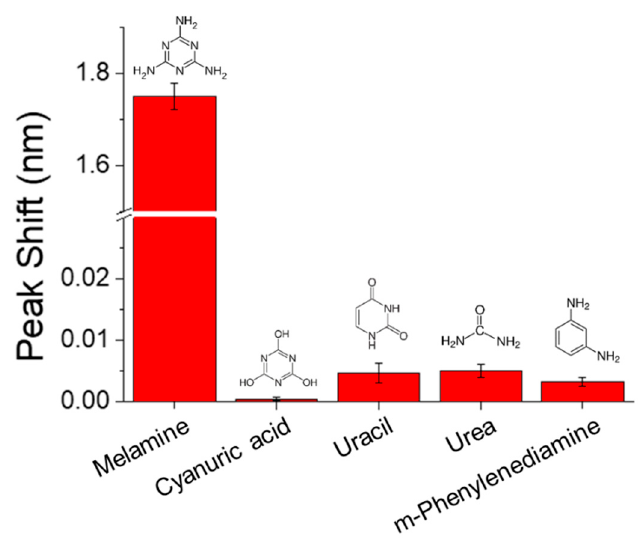
Figure 4. Melamine selectivity of p -NA-based cuvette-type LSPR sensor from DW additionally containing various harmful additives such as melamine, cyanuric acid, uracil, urea, and m-phenylenediamine. The concentration of melamine and the other substances are 100 ppb. All experiments were performed with five measurements, and the data represent mean ± standard deviation. The coefficient of variation (% CV) is below 10%.